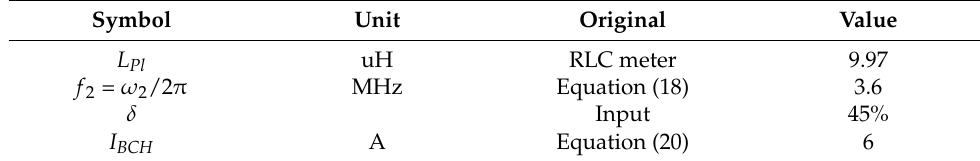
Table 3. Calculation of the charging current provided with parameters in Tables 1 and